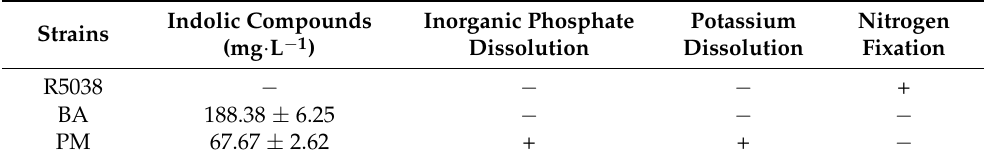
Table 1. Characteristics of the three